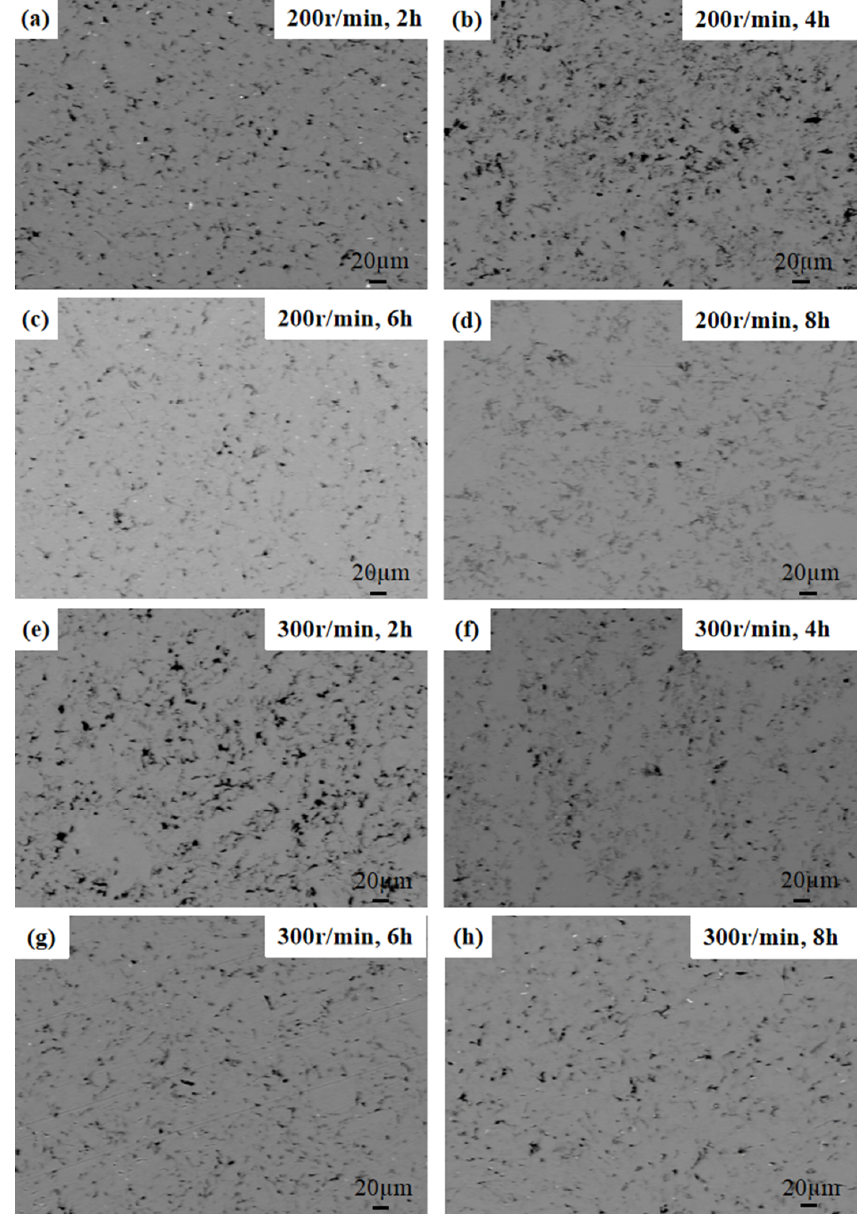
Figure 11. Optical microscope morphology of the vacuum hot-pressed composite. ( a )–( d ) 200 r/min; ( e )–( h ) 300 r/min.